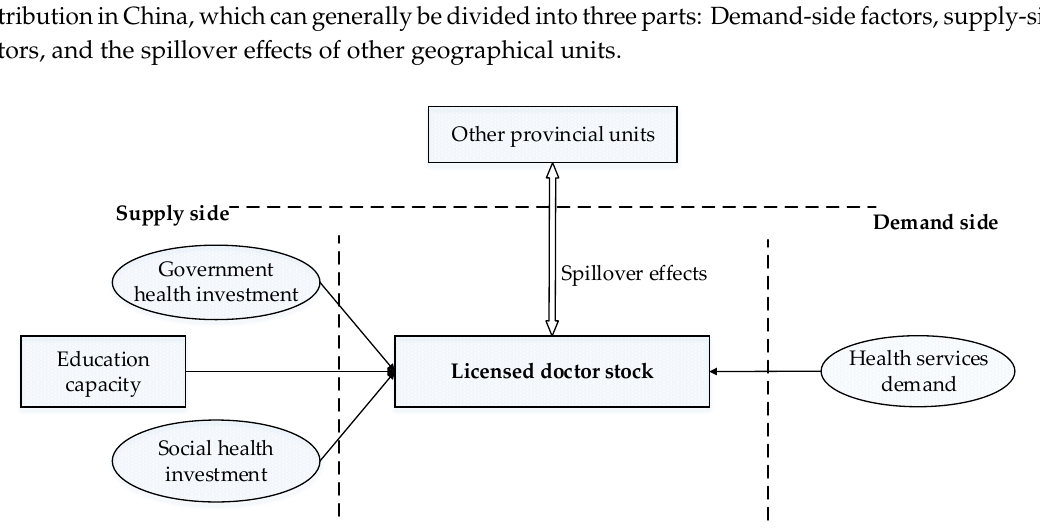
Figure 1. Research model of the determinants of licensed doctor distribution [4].